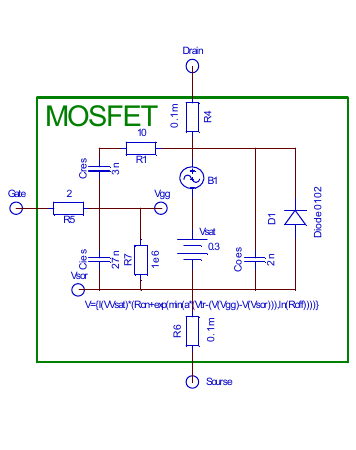
Figure 18. Model of CM450DX-24S1. This model uses the same exponential function of impedance change as in the pre-